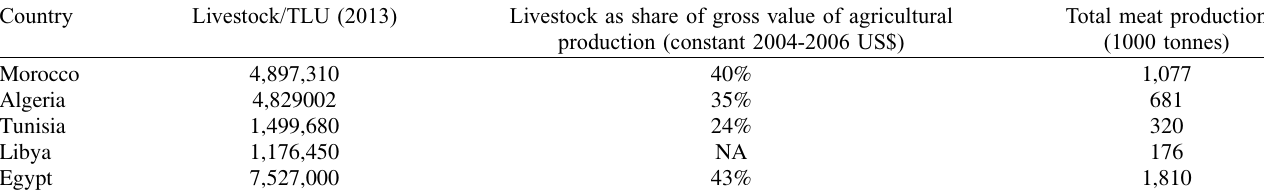
Table 2. Livestock indicators in North Africa,